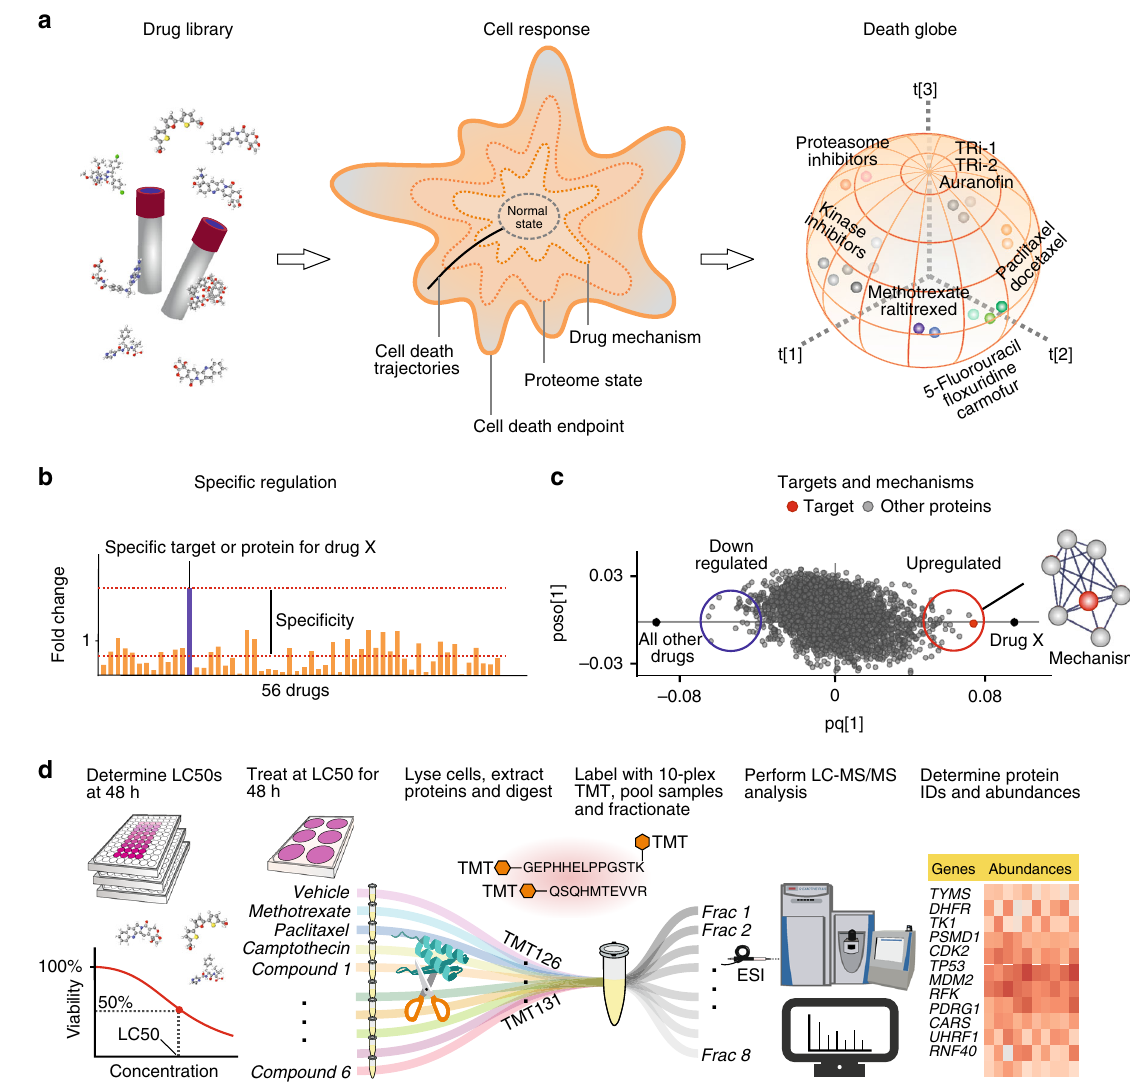
Fig. 1 ProTargetMiner strategy and work fl ow. a an extensive proteome signature database of anticancer molecules will identify compounds with similar MOA in multidimensional space. b since the response of the target and mechanistic proteins to a compound is speci fi c, c an OPLS-DA model contrasting the given compound with all other molecules in the database will identify the drug targets (red circles) and mechanistic proteins as speci fi cally regulated proteins (among other proteins shown with gray circles). d work fl ow: determination of LC50 values for the library of compounds and selected cells; cell treatment with 56 compounds as well as vehicle-treated control and standard treatments (methotrexate, paclitaxel and camptothecin) in at least three biological replicates; lysis, digestion and labeling with TMT-10plex reagents; multiplexing the 10-plexed samples; fractionation of the pooled sample to increase the proteome coverage; analysis of individual fractions by LC-MS/MS; protein identi fi cation and relative quanti fi cation; data post-processing. The compound structures in panel a were taken from